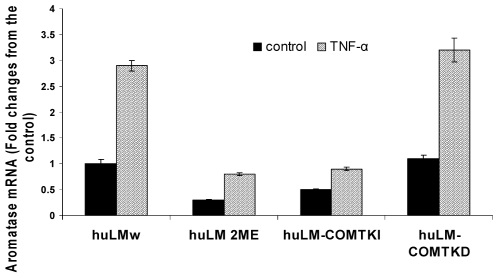
Effect of COMT expression or treatment with 2ME (500 nM) on basal and TNF-α-induced CYP19 mRNA expression in huLMW, huLM2ME, huLM-COMTKD, and huLM-COMTKI .Cells were treated with TNF-α (20 ng/ml) for 48 hours. CYP19 mRNA expression levels were measured by real-time RT-PCR and were normalized to GAPDH mRNA. Levels are reported as fold change compared with basal level detected in huLMW.